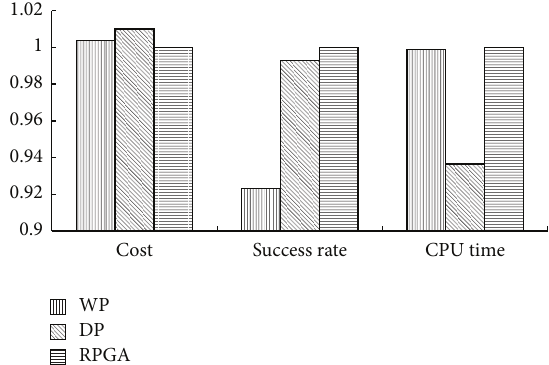
Figure 8: Comparison with different penalty methods (in percent- age relative to the